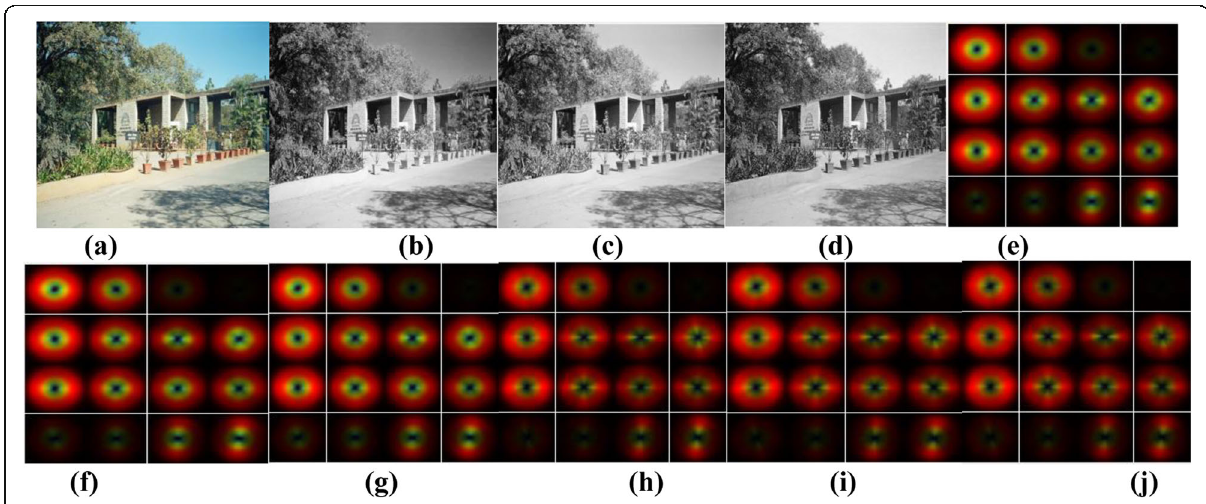
Fig. 5 Visual illustration of Color-GIST descriptor. a RGB outdoor image; b Red channel (RGB image); c Green channel (RGB image); d Blue channel (RGB image); e - g Color-GIST descriptor extracted applying 32 Gabor filters at 4 scales and 8 orientations from red channel ( e ) green channel ( f ) and blue channel ( g ); h - j Color-GIST descriptor extracted applying 64 Gabor filters at 4 scales and 16 orientations from red channel ( h ) green channel ( i ) and blue channel ( j )